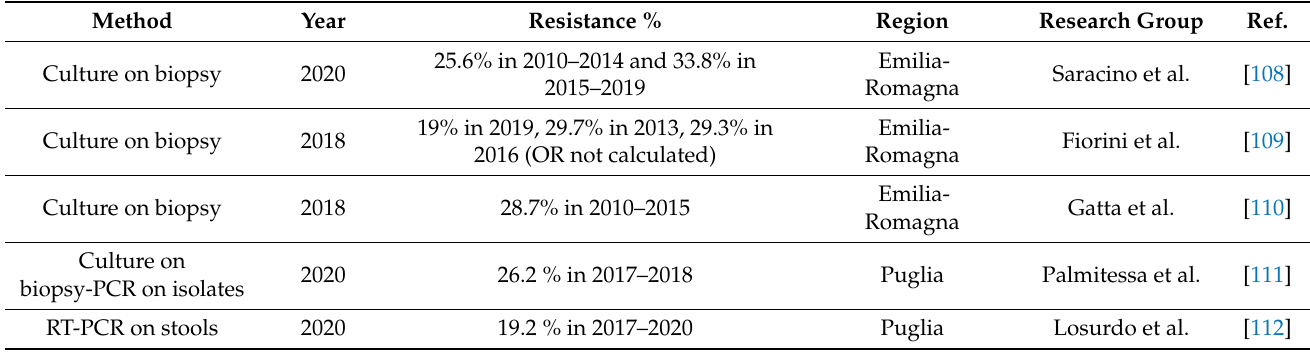
Table 2. Primary levofloxacin resistance in Italy.